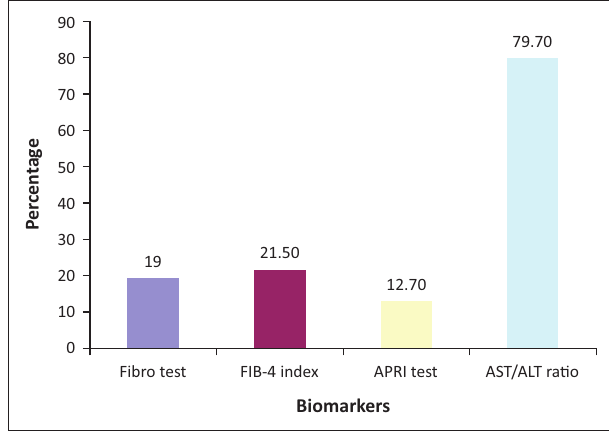
FIGURE 1: Prevalence of hepatic fibrosis as determined by non-invasive biomarkers. The figure shows the prevalence ( % ) of significant liver fibrosis in antiretroviral therapy-experienced participants as determined by the non- invasive algorithms (FibroTest 19 % , Fibrosis-4 [FIB-4] index 21.5 % ,